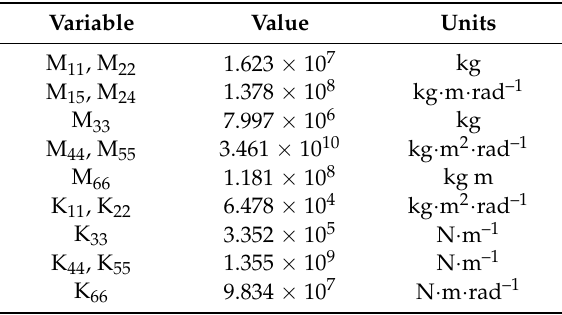
Table 3. Mass and stiffness matrices of the structure.